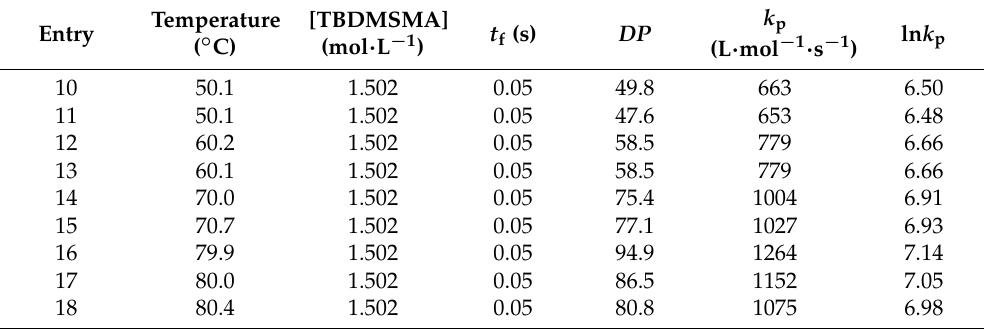
Table 2. k p values obtained from PLP-SEC investigations of free-radical polymerization of TBDMSMA in toluene for different